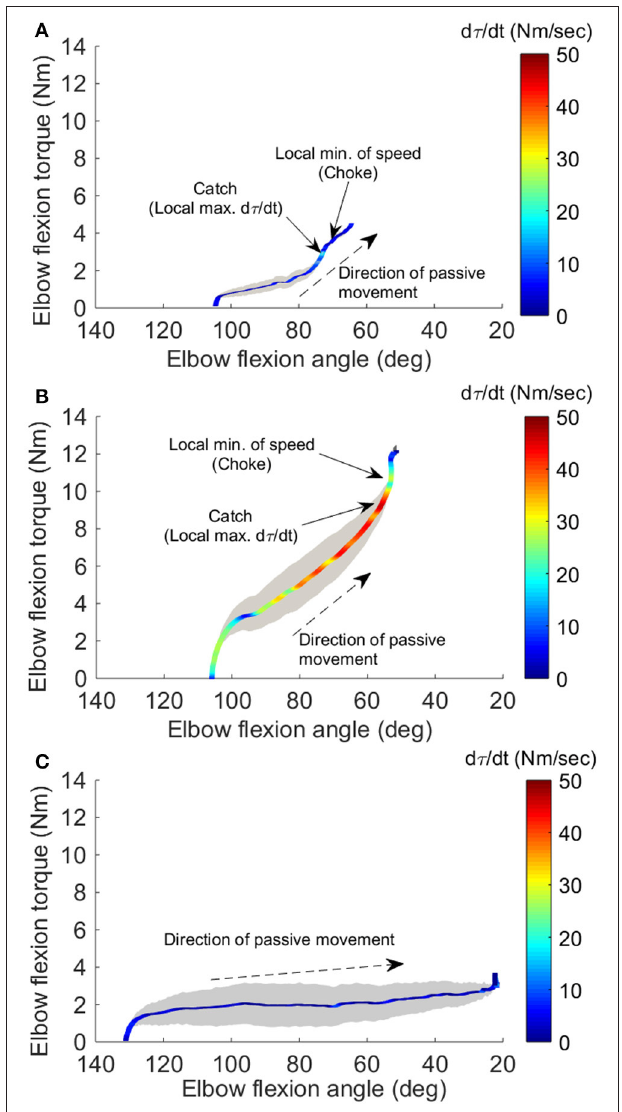
FIGURE 3 | Four-dimensional characterization of the spastic muscles. Four variables: elbow flexion angle, elbow flexion torque, velocity, and torque change rate d τ (t)/dt, during the passive stretch were plotted simultaneously for a representative stroke survivor at 90 ◦ /sec (A) , at 270 ◦ /sec (B) , and a healthy control at 270 ◦ /sec (C) . The X-axis and Y-axis correspond to the elbow flexion angle and torque, respectively. The resistance torque generated by the stretched flexor muscles is positive. The dashed arrow indicates the direction of movement. Velocity is proportional to the width of the gray shaded area. The color of the line gives d τ (t)/dt, with the hot color (red) corresponding to a high rate of d τ (t)/dt. The two small arrows in (A) indicate the local maximum of d τ (t)/dt where the catch occurred and local minimum of velocity resulting from the examiner’s reaction to the abruptly increased torque, respectively.